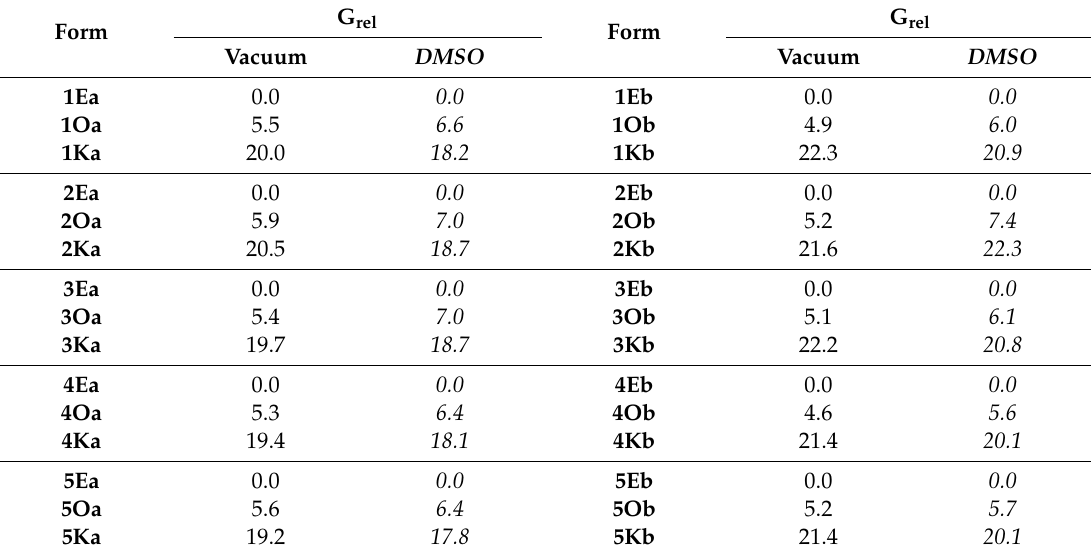
Table 2. Calculated (M06-2X/def2-TZVP) relative [kcal/mol] Gibbs free energies for 2-(aniline- Table 2.